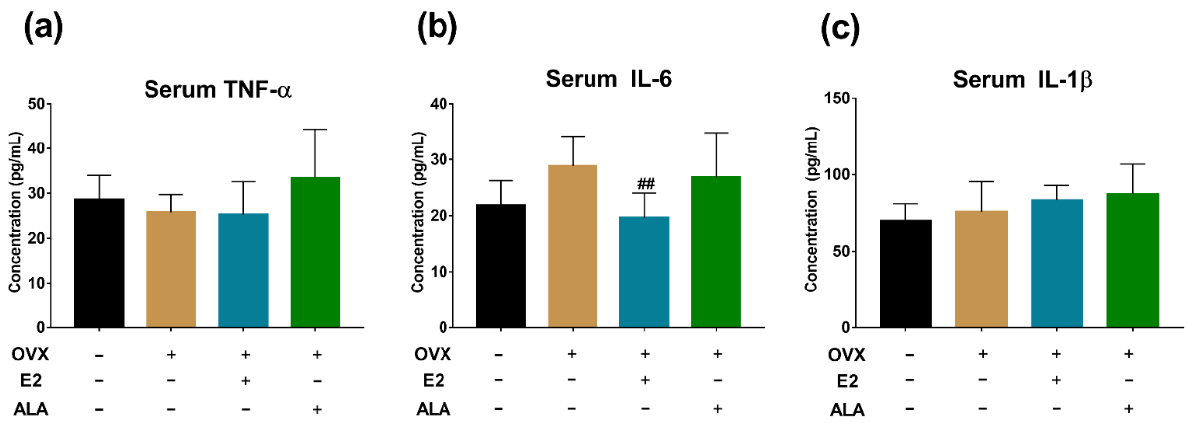
Figure 7. Effects of ALA therapeutic intervention on the expression levels of serum inflammatory factors. The expression levels of ( a ) TNF- α, ( b ) IL-6 and ( c ) IL- 1β in serum of ovariectomized rat models with or without ALA therapeutic intervention were measured by ELISA. ## p < 0.01 vs. the OVX group (OVX (+), E2 (−), ALA (−)).